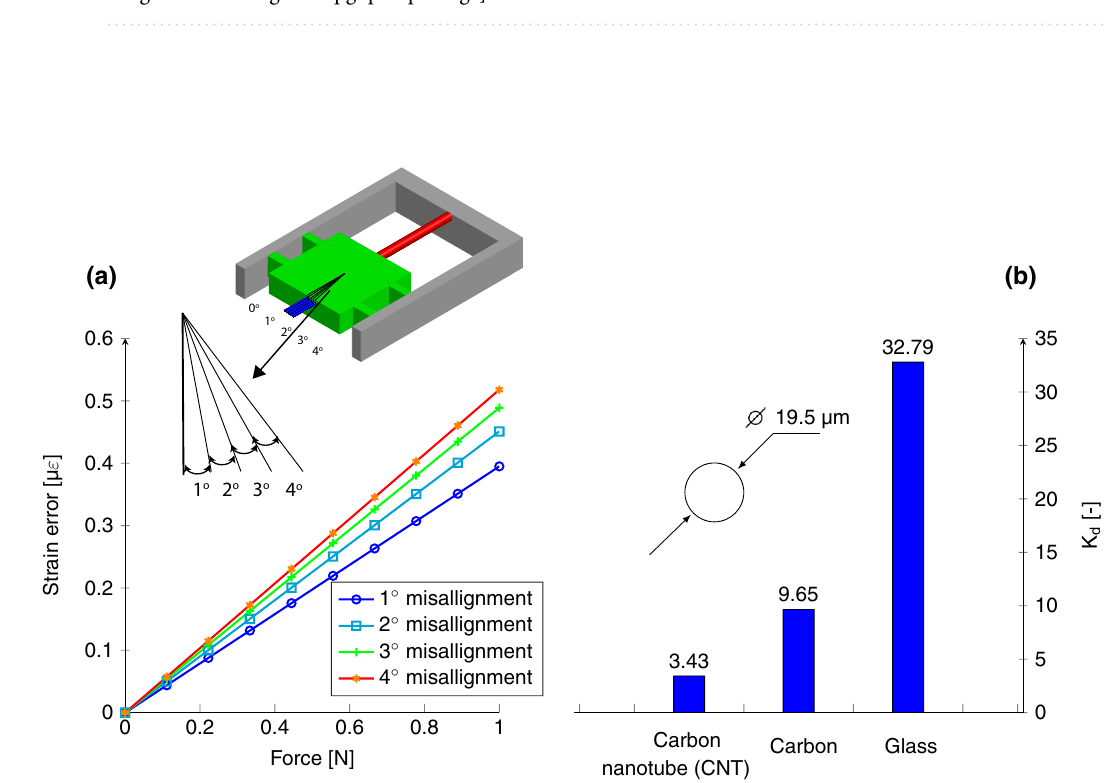
Figure 6. FEA to determine the predicted solutions of: ( a ) error in the FBG strain when a filament is incorrectly fixed to the stage: ε ideal − ε mis ; ( b ) the K d values for different types (material) of filaments for a filament diameter of 19.5 µ m (filaments are modelled as linear elastic with modulus of 600 GPa 21 , 238 GPa 22 and 86 GPa 23 for CNT, carbon and glass, respectively). [The graphs are generated using latex-pgf plot